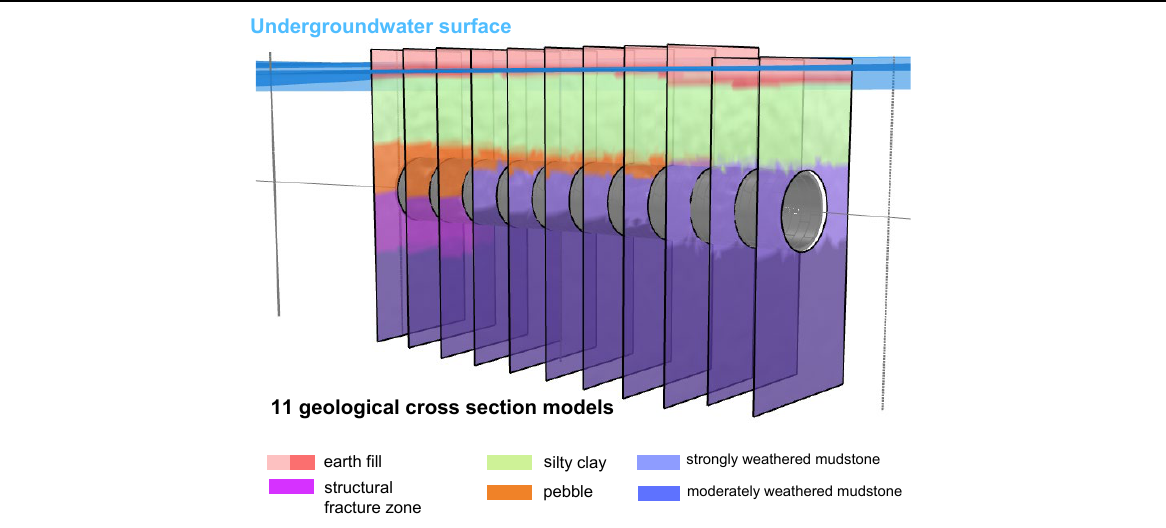
Figure 6 . Geological cross-section modelled by the proposed parametric method